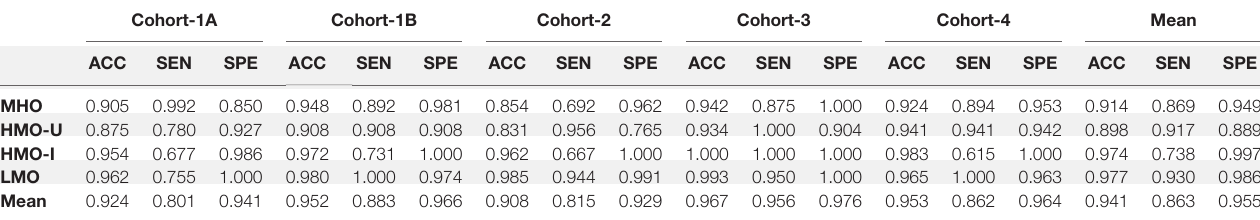
TABLE 3 | Performance of assigning patients in each veri fi cation cohort to the four clusters generated by k-means on the main cohort, Cohort-1. Cohort-1A Cohort-1B